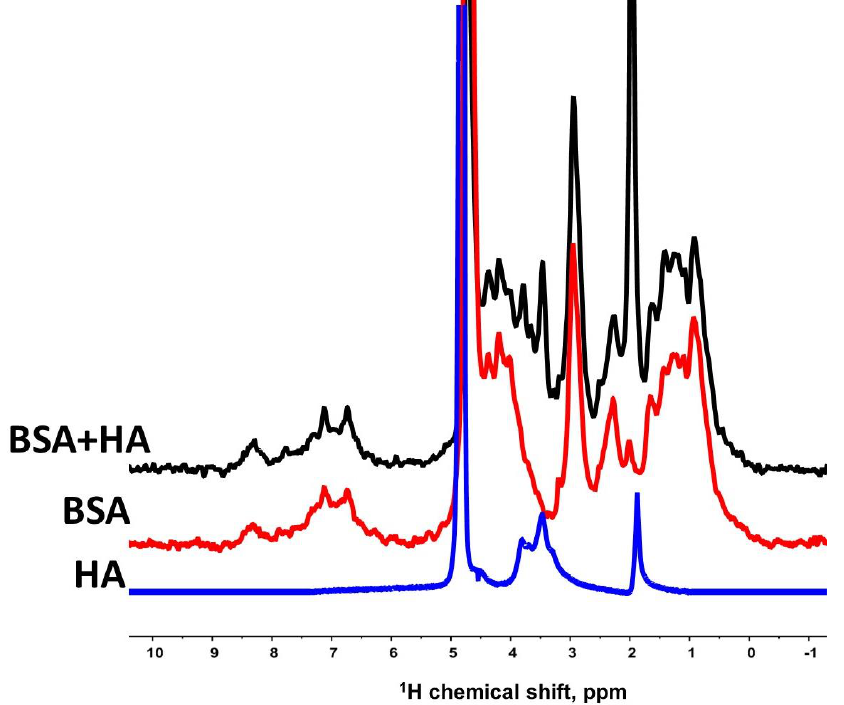
Figure 1. Proton NMR spectra of certain samples. BSA + HA—solution of albumin and HA at a protein concentration of 4% (wt.) and 0.75% hyaluronate; BSA—solution of BSA at a concentration of proteins 4% (wt.); HA—aqueous solution of HA with a polysaccharide concentration of 0.75% (wt.). Spectral data were recorded at 298 K.